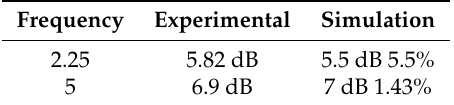
Table 4. Comparison of backwall echo difference between experimental and simulated results.